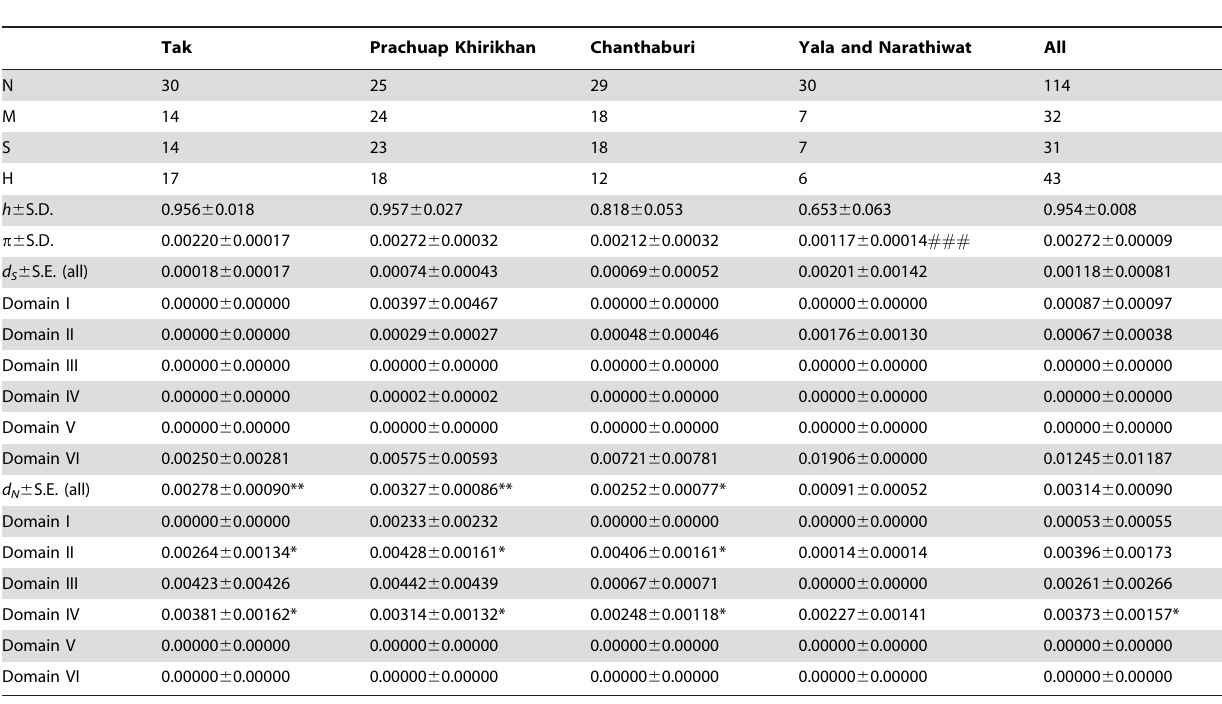
Table 2. Variation in the PvTRAP sequences of Thai isolates from diverse endemic